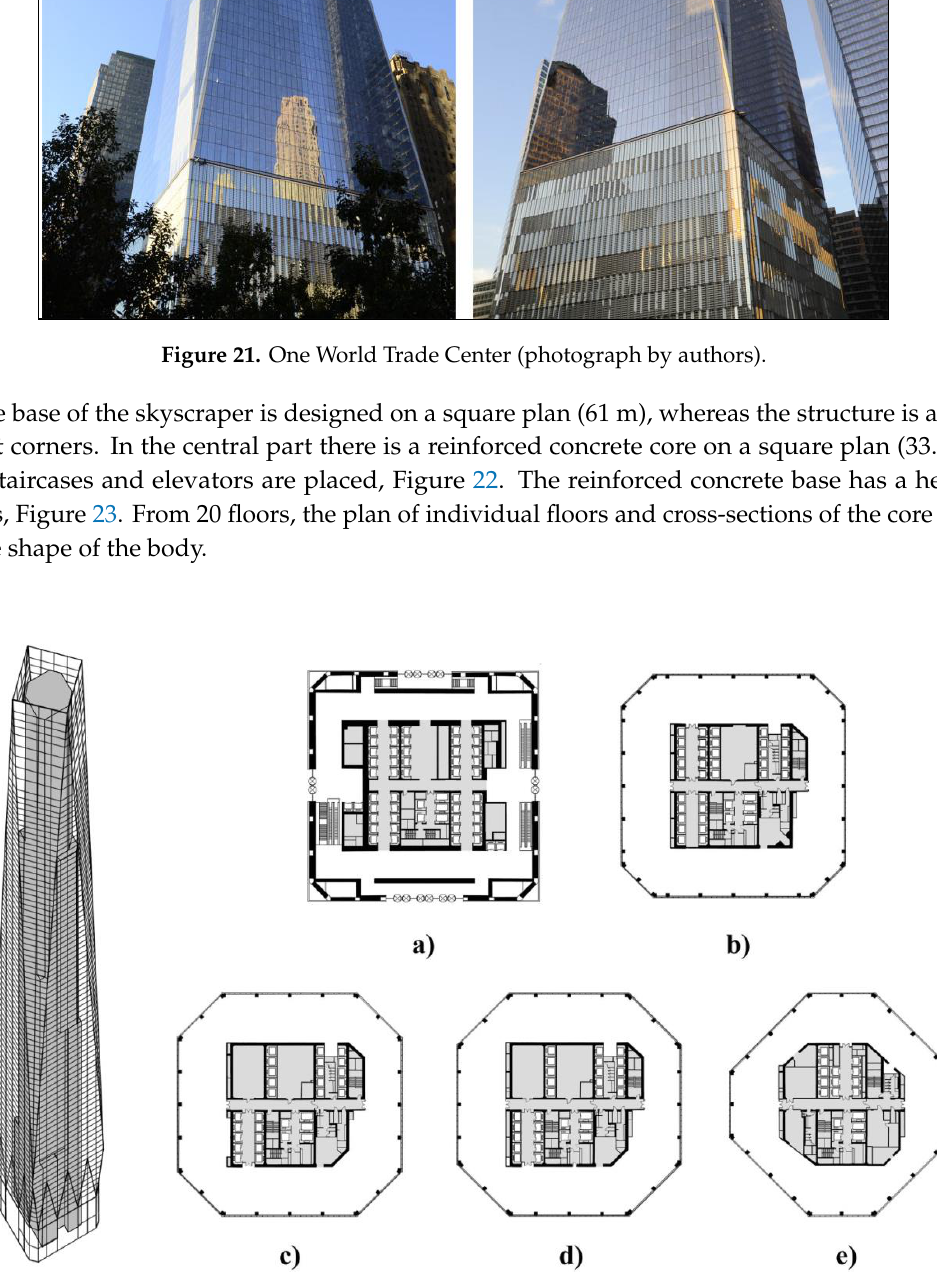
Figure 23. One World Trade Center: Reinforced concrete base with aluminum claddings and glass panels mounted in special profiles (photograph by authors). Ultra-high-strength concrete used for thick concrete walls of the core, referred to as mass concrete, required a concrete mix to fulfill the most stringent requirements. All mixtures, depending on the needs, contained additional cement materials, fly ash, granulated lump slag cement and silica fume [49]. Due to the high height and slenderness of the building structure, the proportions of the concrete mix for the core were designed taking into account creep, shrinkage and modulus of elasticity.